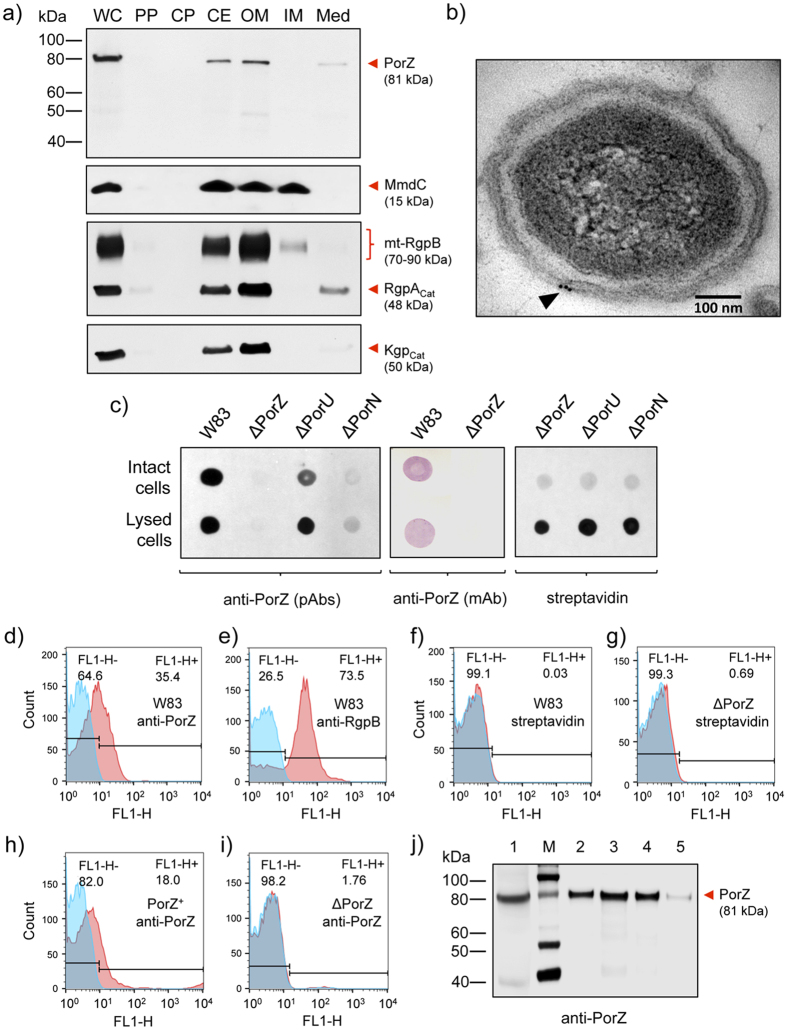
PorZ is located on the cell surface of P. gingivalis.(a) Wild-type P. gingivalis cells (W83) were proportionately fractionated into whole cell extract (WC), periplasm (PP), cytoplasm (CP), cell envelope (CE), outer membrane (OM), inner membrane (IM) and growth medium (Med), and subsequently analyzed by Western blotting using mouse polyclonal anti-PorZ and anti-Rgp antibodies and mouse monoclonal anti-Kgp antibodies. Streptavidin conjugated to horseradish peroxidase was used to detect MmdC, a biotinylated IM-associated protein. Presence or absence of full-length PorZ (81-kDa band) and other proteins is indicated. (b) Wild-type cells were probed with monoclonal anti-PorZ antibodies and labeled with immunogold to visualize the cellular location of PorZ (black arrowhead) in electron microscopy (bar = 100 nm). (c) Dot blot analysis of intact and lyzed wild-type (W83), ΔPorZ, ΔPorU and ΔPorN cells using mouse monoclonal anti-PorZ antibodies (mAb), mouse polyclonal anti-PorZ antibodies (pAb) or streptavidin conjugated to horseradish peroxidase. Flow cytometry analysis showing the surface exposure of (d) PorZ in wild-type cells (W83) with anti-PorZ pAb; (e) RgpB in wild-type cells (W83) with monoclonal anti-RgpB antibodies (positive control); (f) MmdC in wild-type cells (W83) and (g) in ΔPorZ cells with streptavidin-Alexa Fluor 488 conjugate; (h) PorZ in in trans porZ-complemented ΔPorZ (PorZ+) cells with pAb and (i) PorZ in ΔPorZ cells with anti-PorZ pAb. Isotype negative controls are in blue and immunoprobed cells in red; the histograms shown are representative of three independent experiments. (j) Presence of full-length PorZ (lane 1) detected by Western blot using anti-PorZ pAb on wild-type cells washed with PBS and suspended, respectively, in distilled water (lane2); in 0.0007% Tween-20 (lane 3); in 0.04% sarcosyl (lane 4); and in 0.02% SDS (lane 5). After 10 min of gentle stirring, cells were removed by centrifugation and the presence of PorZ in the cell pellet (lane 1) and supernatants (lanes 2–5 was checked). The detergent concentrations correspond to one-tenth of the critical micelle concentration (CMC). Lane M, MagicMark™ XP Western Protein Standard.